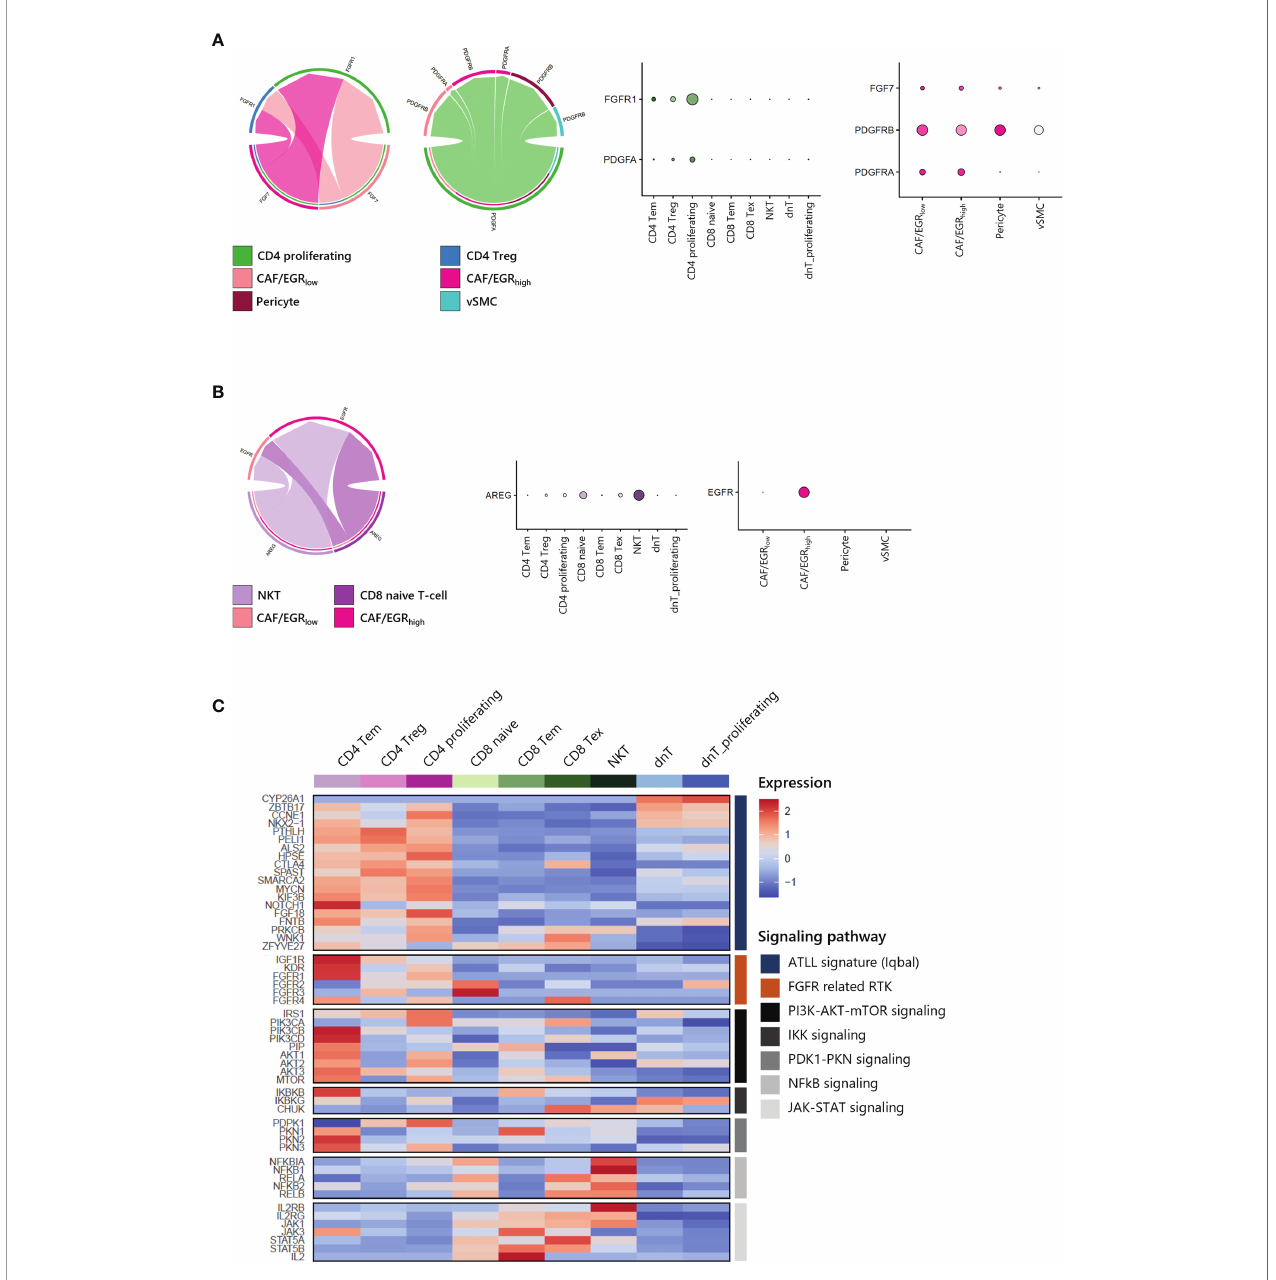
FIGURE 7 | Cell-cell interactions within ATLL (A) FGF and PDGF signaling between CD4 T-cells and CAFs (B) EGF and AREG signaling between CD8 T-cells and CAF/EGR high (C) Signaling pathways in T-cell